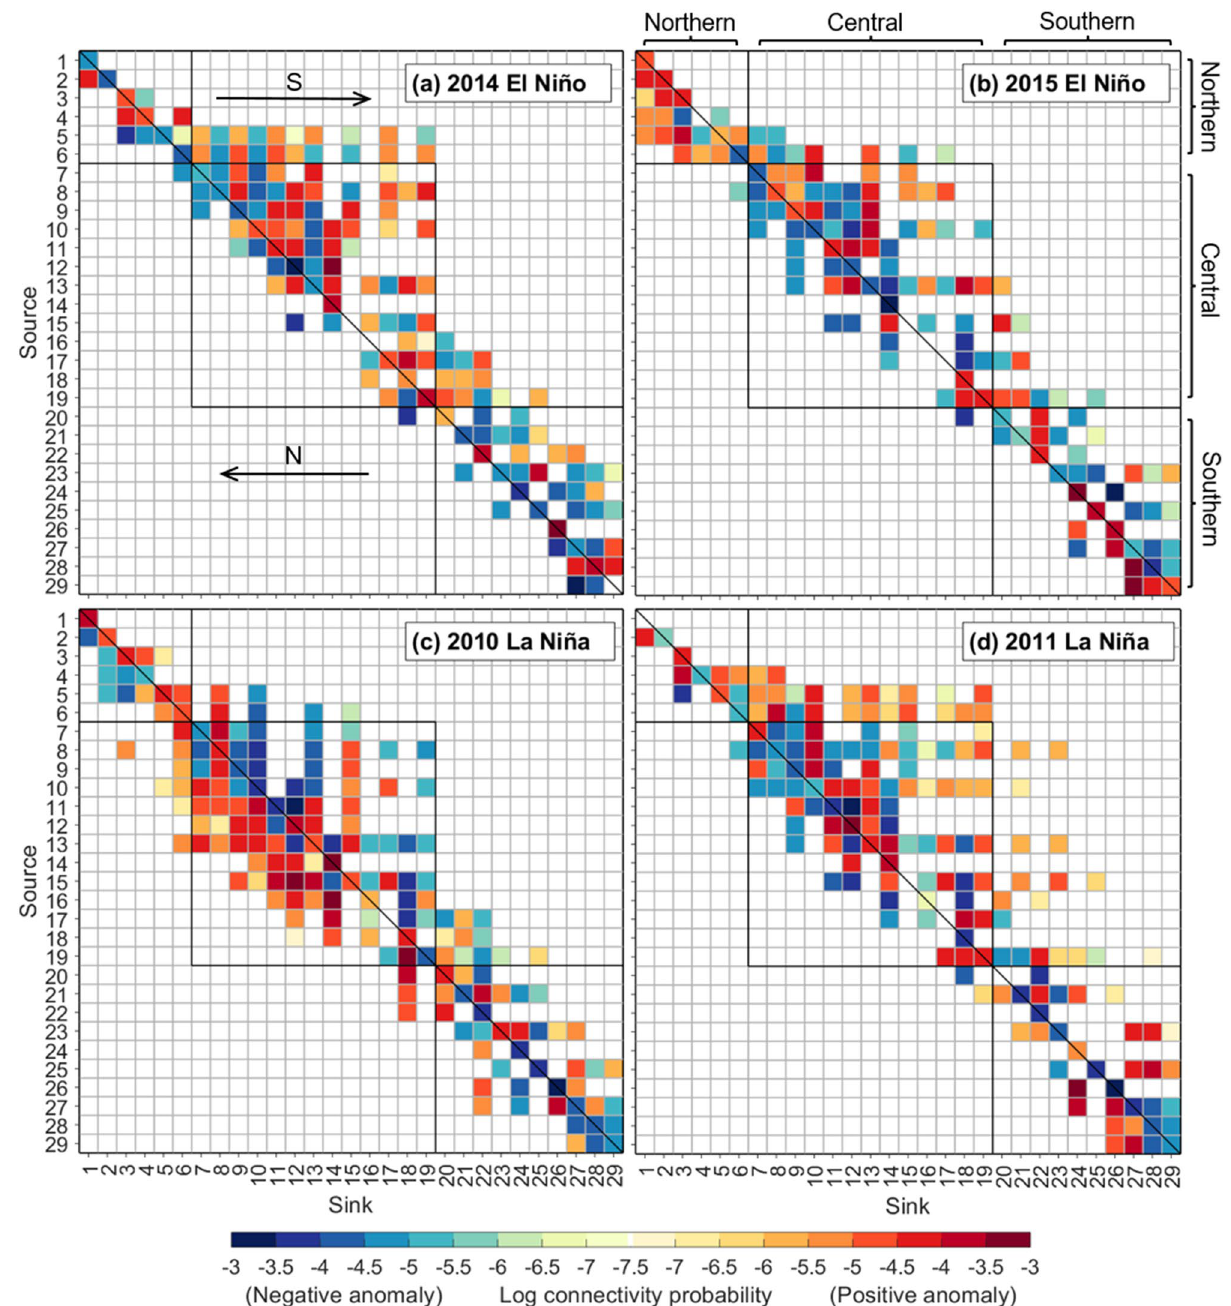
Figure 4. Connectivity matrices for modelled L. carponotatus larvae in the GBR, during ( a ) 2014 El Niño alert, ( b ) strong 2015 El Niño, ( c ) very strong 2010 La Niña, and ( d ) moderate 2011 La Niña. Positive and negative anomalies (referenced to the 2010–2017 mean connectivity) are represented by darker red–lighter orange and darker blue–lighter green shades (i.e. higher–lower values for both). Values along the diagonal represent larval retention, and values to the right or left of the diagonal indicate poleward (“S”) or equatorward (“N”) connectivity. Northern, central and southern GBR sectors are bordered by black lined squares. Regions are ordered from north to south following the same order as presented in the legend of the upper inset in Fig. 1. The figure was created using MATLAB v9.4, available at https:// www. mathw orks. com/ produ cts/ matlab.